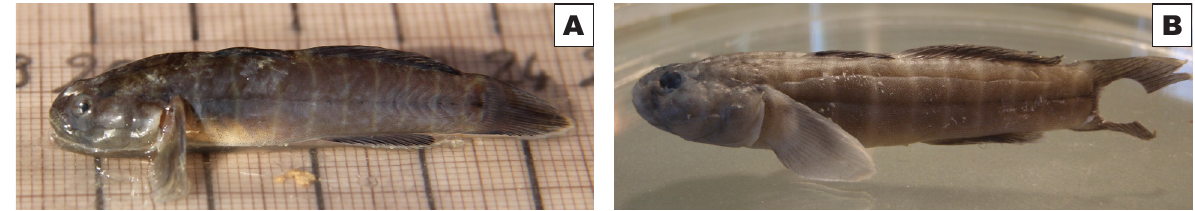
Fig. 2. First specimen of Gobiosoma bosc caught in Belgium: ( A ) freshly caught, ( B ) after preservation in ethanol and removal of caudal fin tissue for DNA